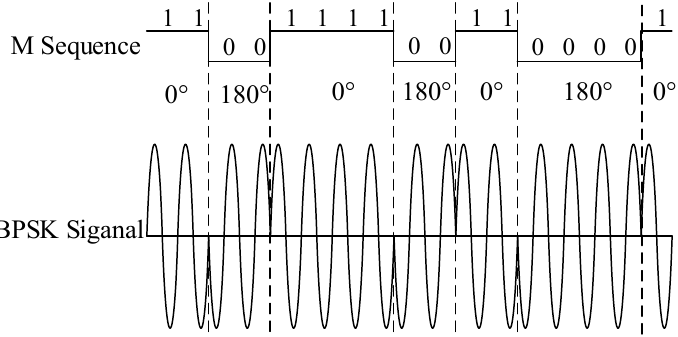
Figure 2. Schematic diagram of m-sequence and sine wave Binary Phase Shift Keyed (BPSK) modulation.